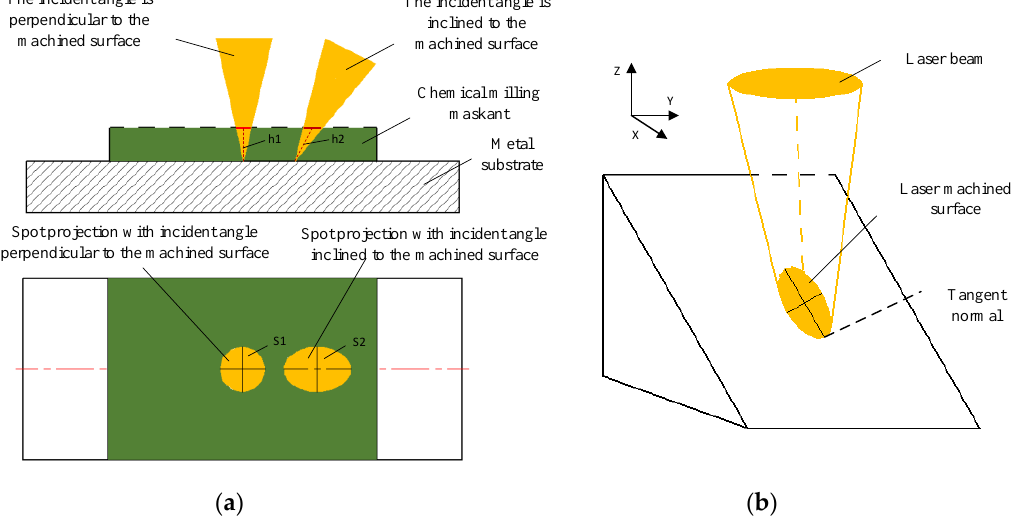
Figure 18. The influence of laser angle. ( a ) The influence of laser beam incidence angle on depth and area; ( b ) 3D sketch of laser beam incidence angle on depth and